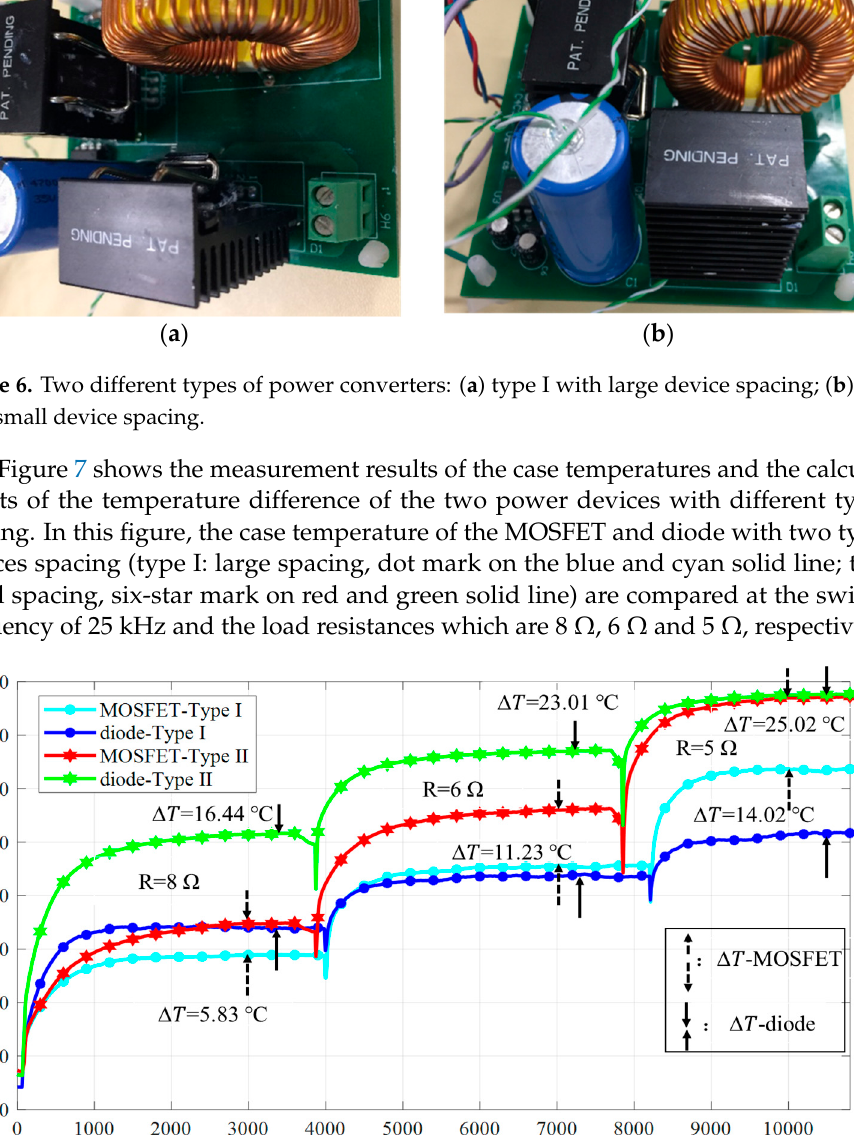
devices with different spacing devices with di ff erent spacing types.